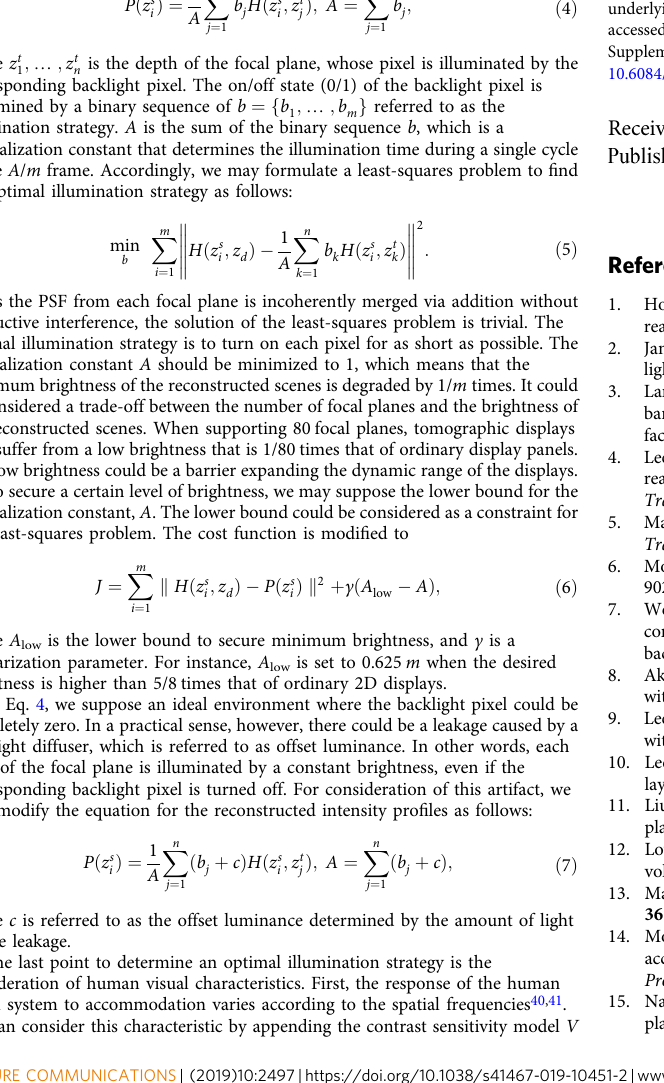
Supplementary Figs. 4 and 7 – 9 are provided as a Source Data File (https://doi.org/ 10.6084/m9. fi